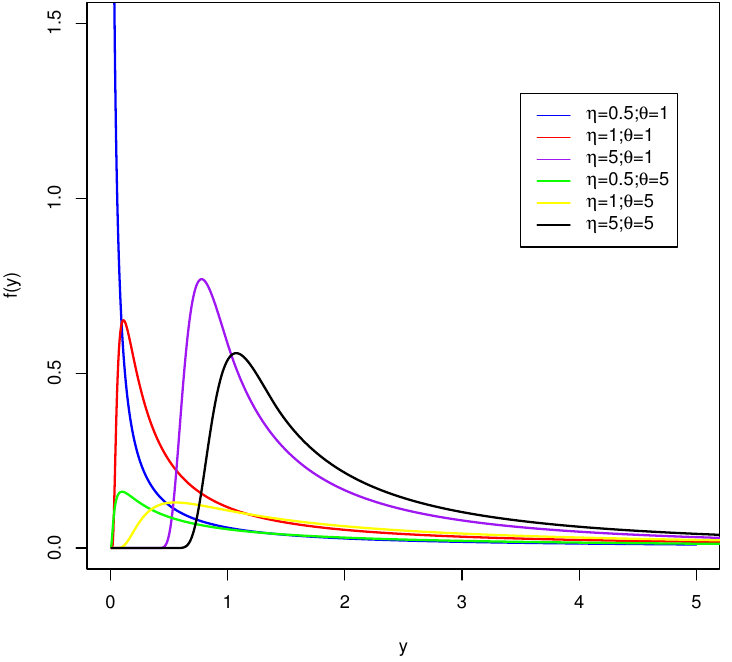
Figure 1. Plots of the exponentiated IG-Pareto density function, for some parameter